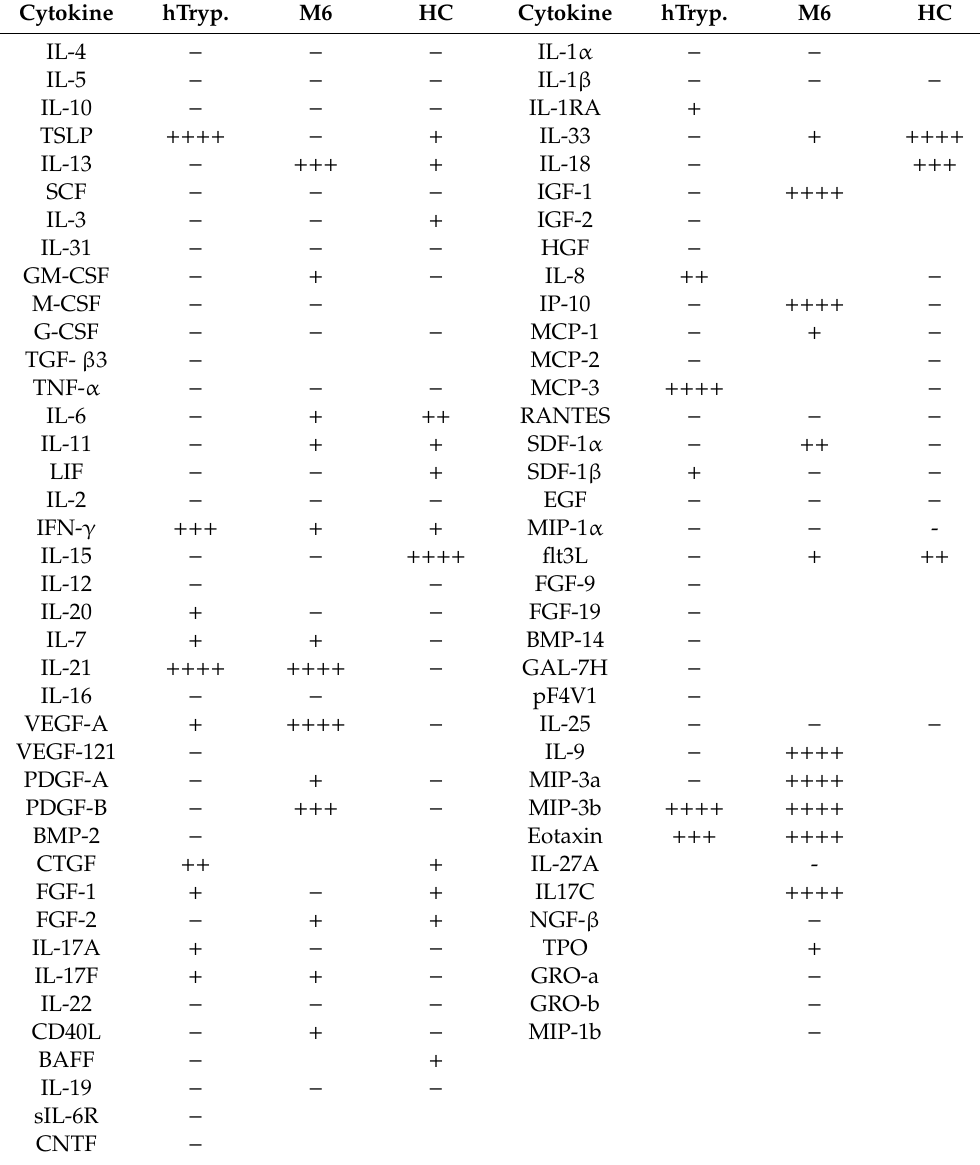
Table 1. Summary of the results from the cleavage analysis of cytokines and chemokines by the human and mouse tryptases and the hMC chymase (HC). Cytokine hTryp.